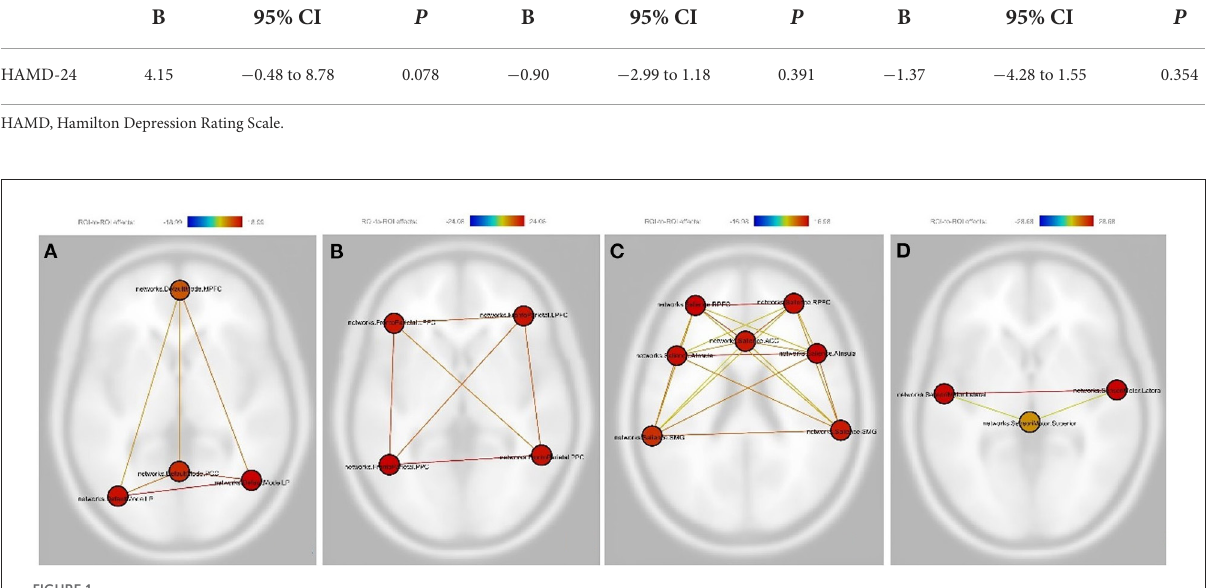
TABLE 2 Comparison of the effects on bright light therapy and dim red light groups using a hierarchical linear model. Treatment effect Time effect Treatment × Time effect